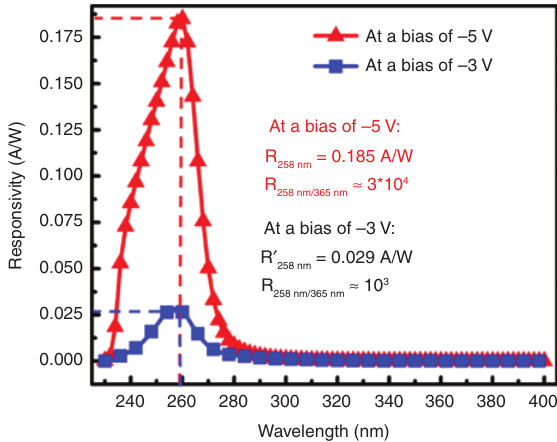
Figure 6: Energy band diagram of the graphene/Ga array heterojunction at UV